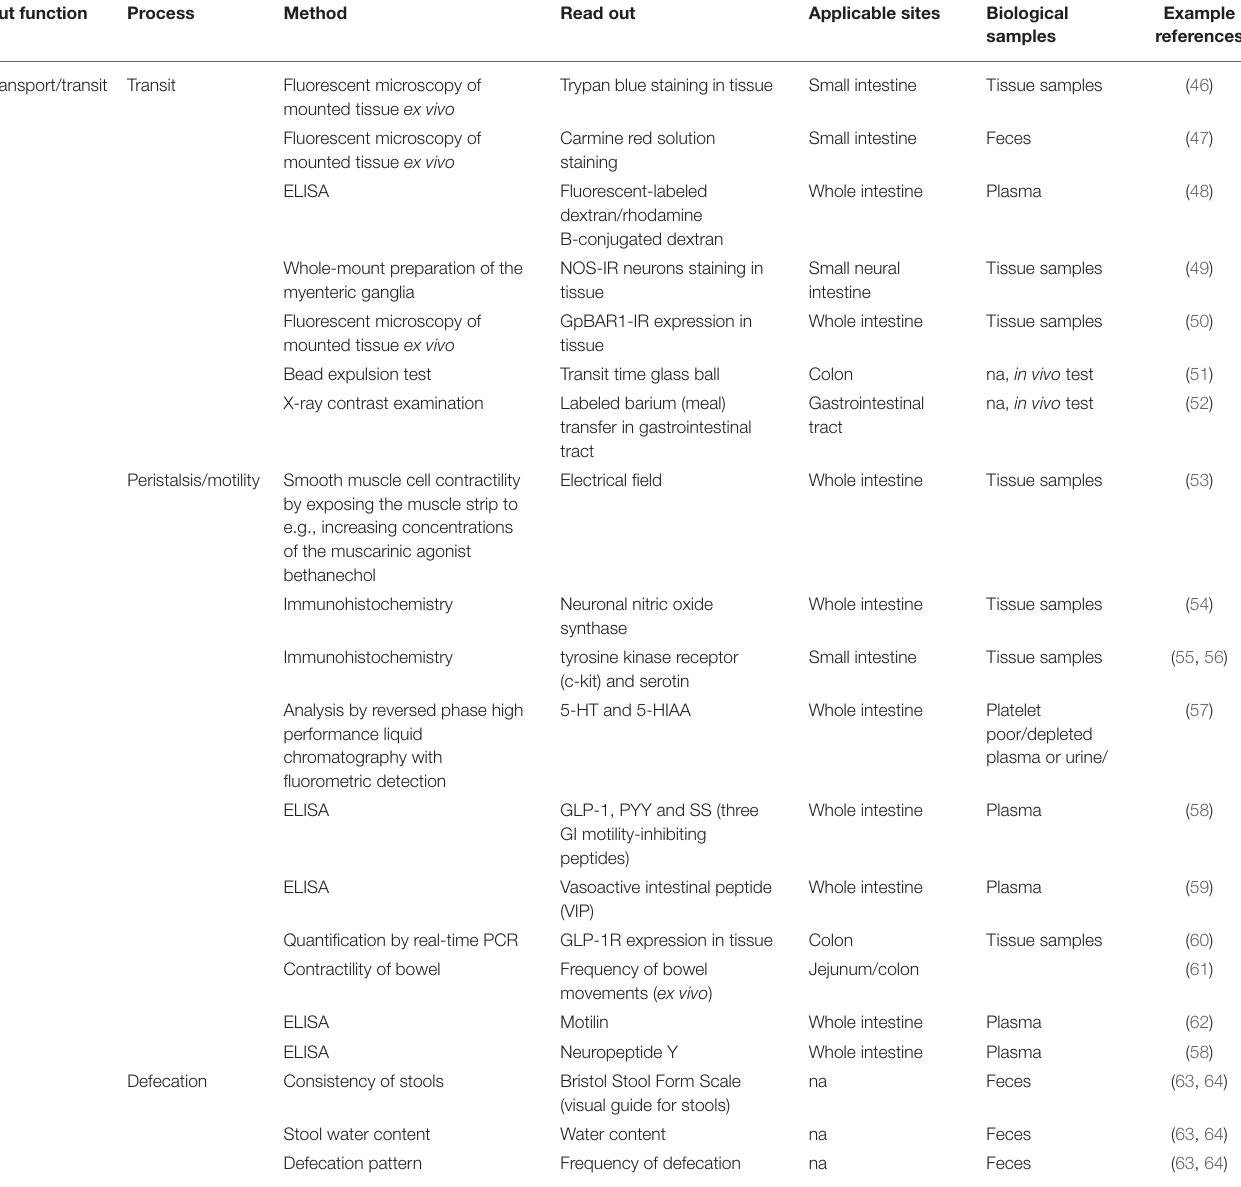
TABLE 1 | Methods described in literature to measure transport and transit ingested